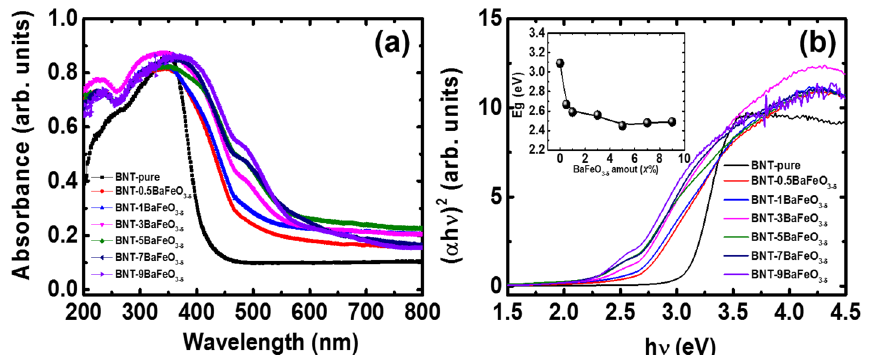
Figure 5. (a) UV–Vis absorption spectra of BaFeO 3− δ -modified Na 0.5 Bi 0.5 TiO 3 samples as a function of BaFeO 3− δ concentration; and (b) the (α hν ) 2 proposal with photon energy ( hν ) of Na 0.5 Bi 0.5 TiO 3 samples as a function of the amount of BaFeO 3− δ added. The inset of (b) shows the optical band gap E g value of Na 0.5 Bi 0.5 TiO 3 samples as a function of the amount of BaFeO 3− δ